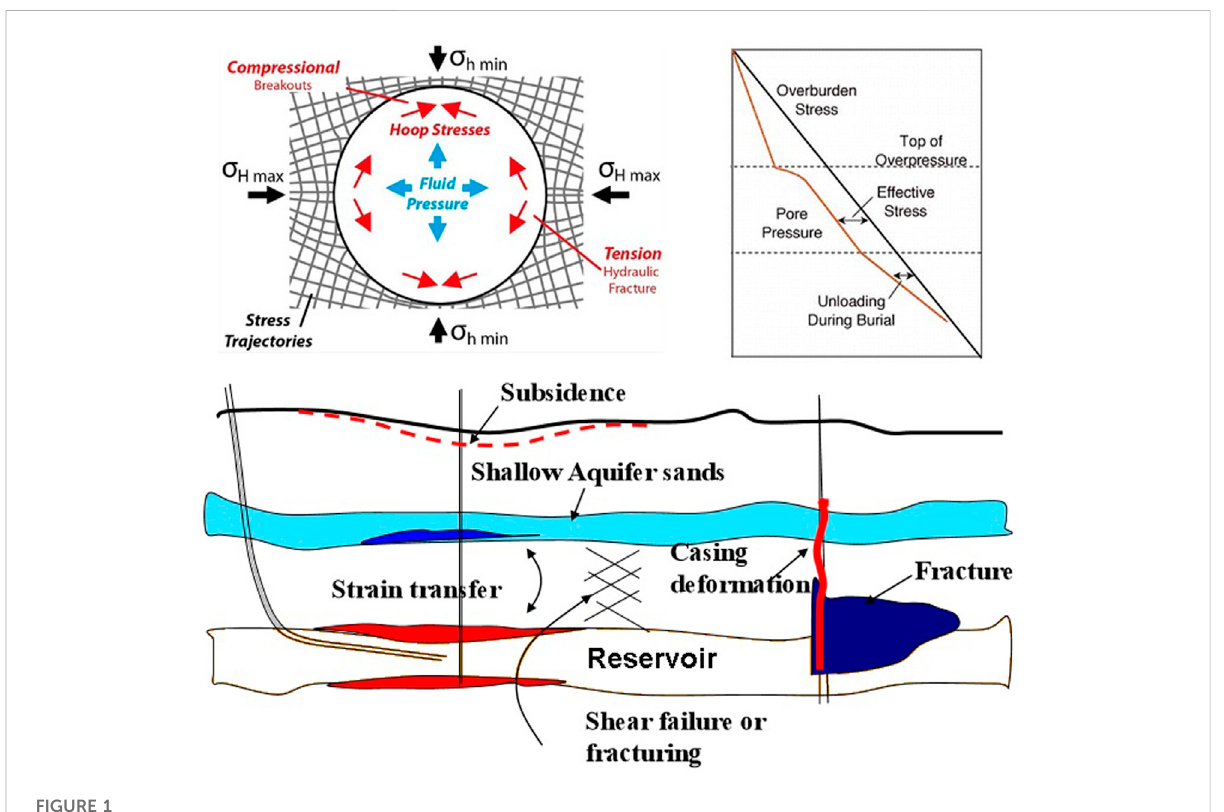
FIGURE 1 Some key concepts in overpressure zones and petroleum